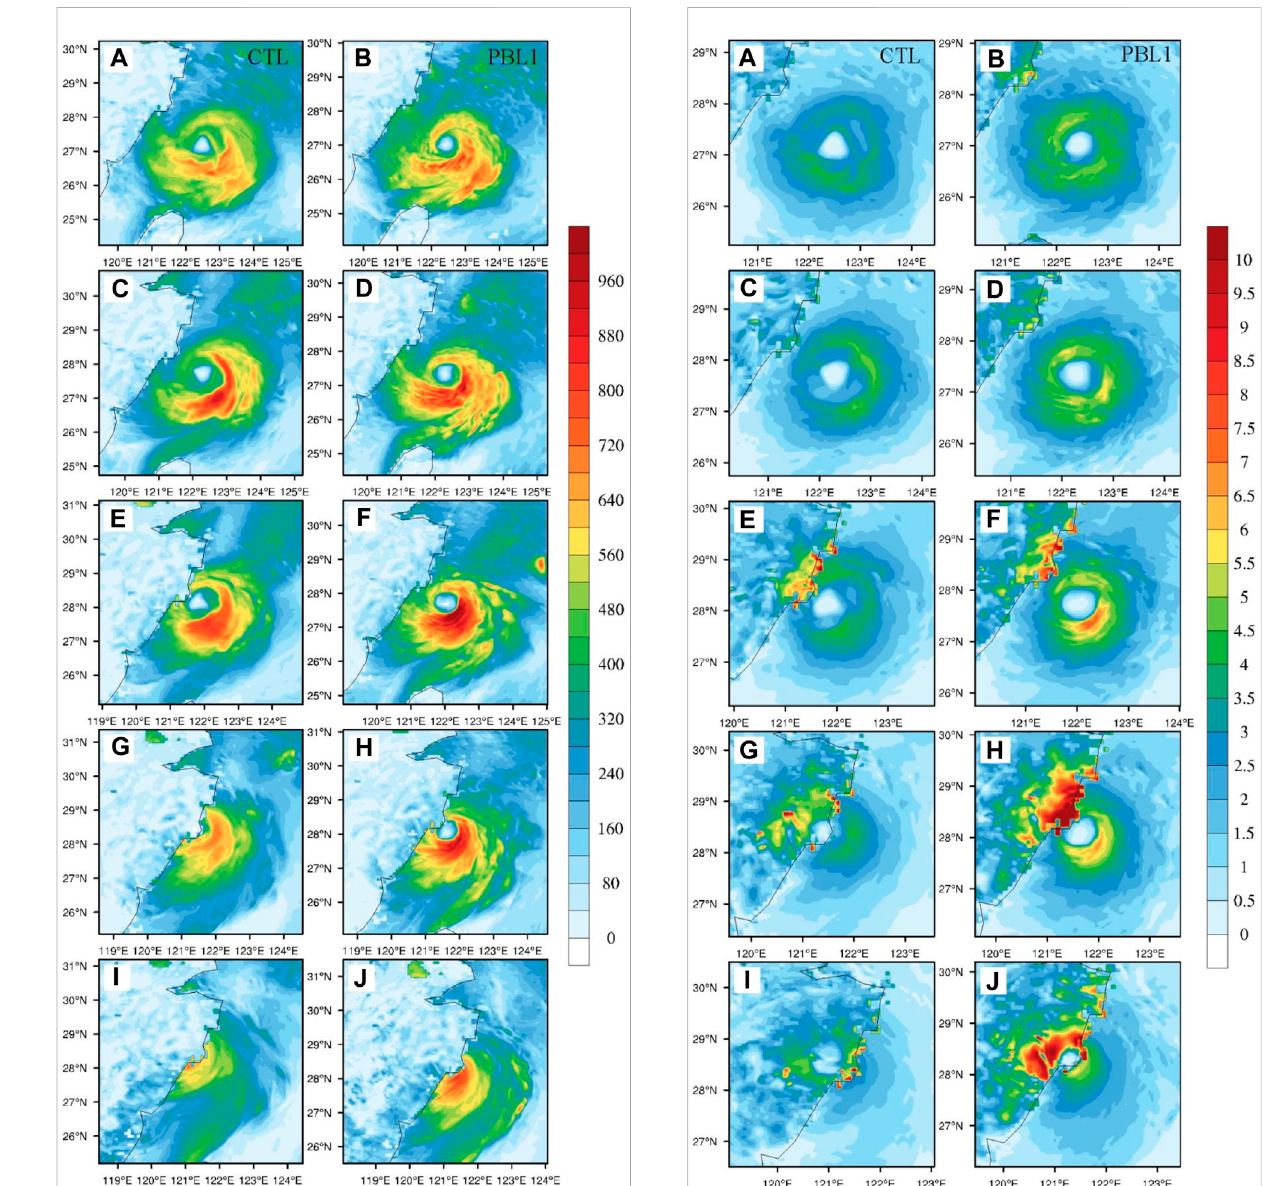
FIGURE 11 Surface latent heat fl ux (unit: W m − 2 ) during 12:00 UTC on 9 August 2019 to 00:00 UTC on 10 August 2019 from (A,C,E,G,I) CTL, and (B,D,F,H,J) PBL1, at (A,B) 12:00 UTC on 9 August, (C,D) 15:00 UTC on 9 August, (E,F) 18:00 UTC on 9 August, (G,H) 21:00 UTC on 9 August, and (I,J) 00:00 UTC on 10 August 2019.